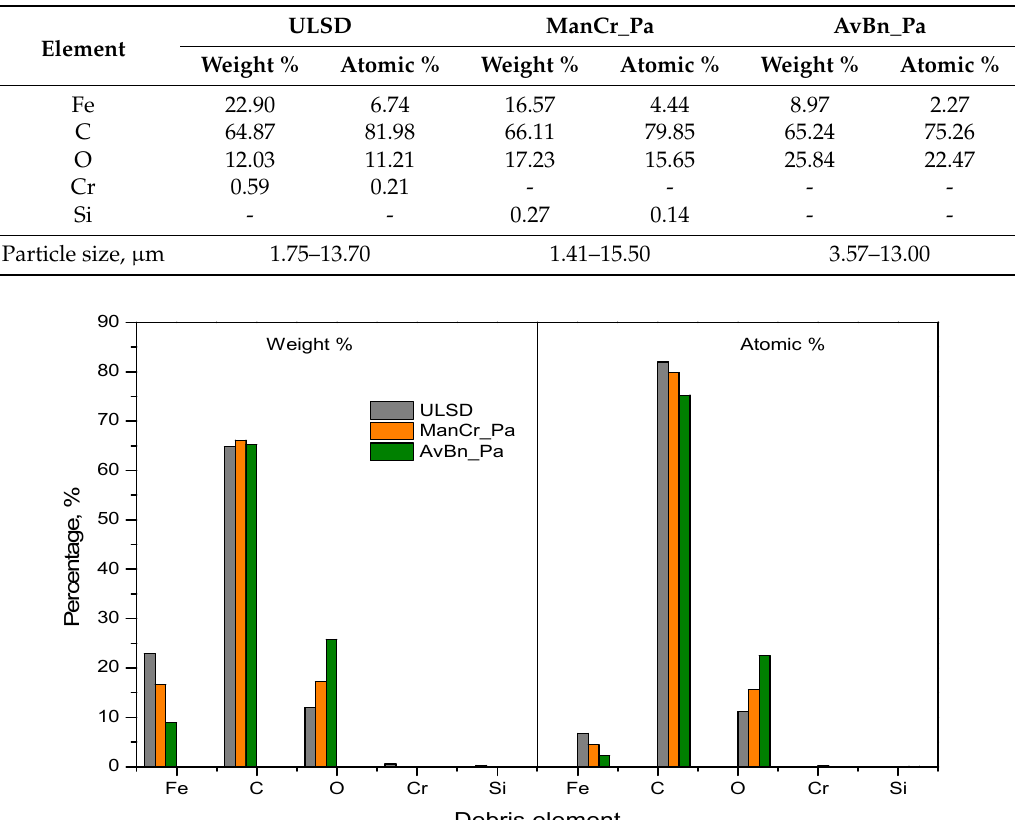
Figure 9. Filtered wear debris analysis by SEM/EDX.